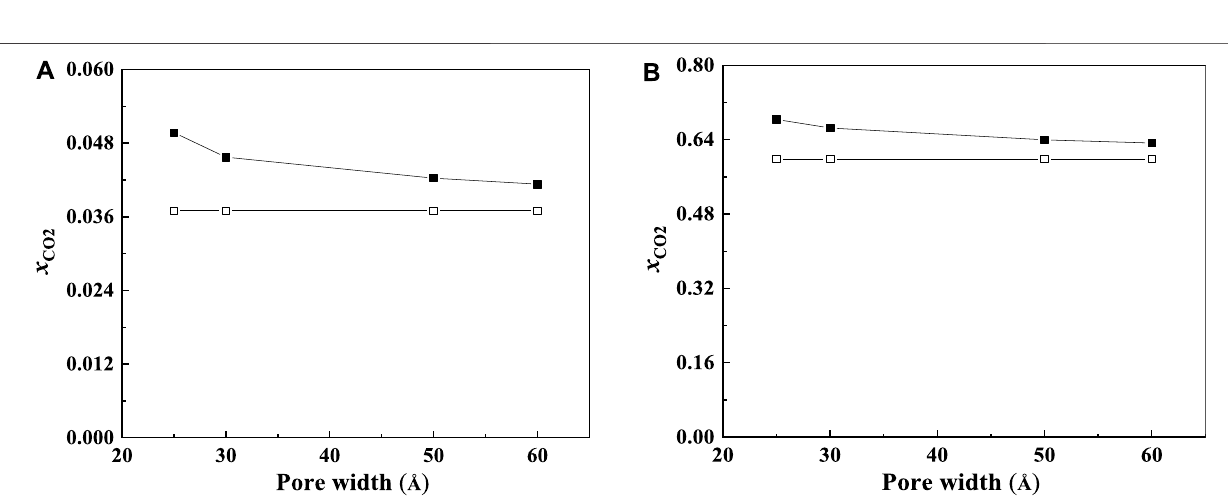
Frontiers in Chemistry |